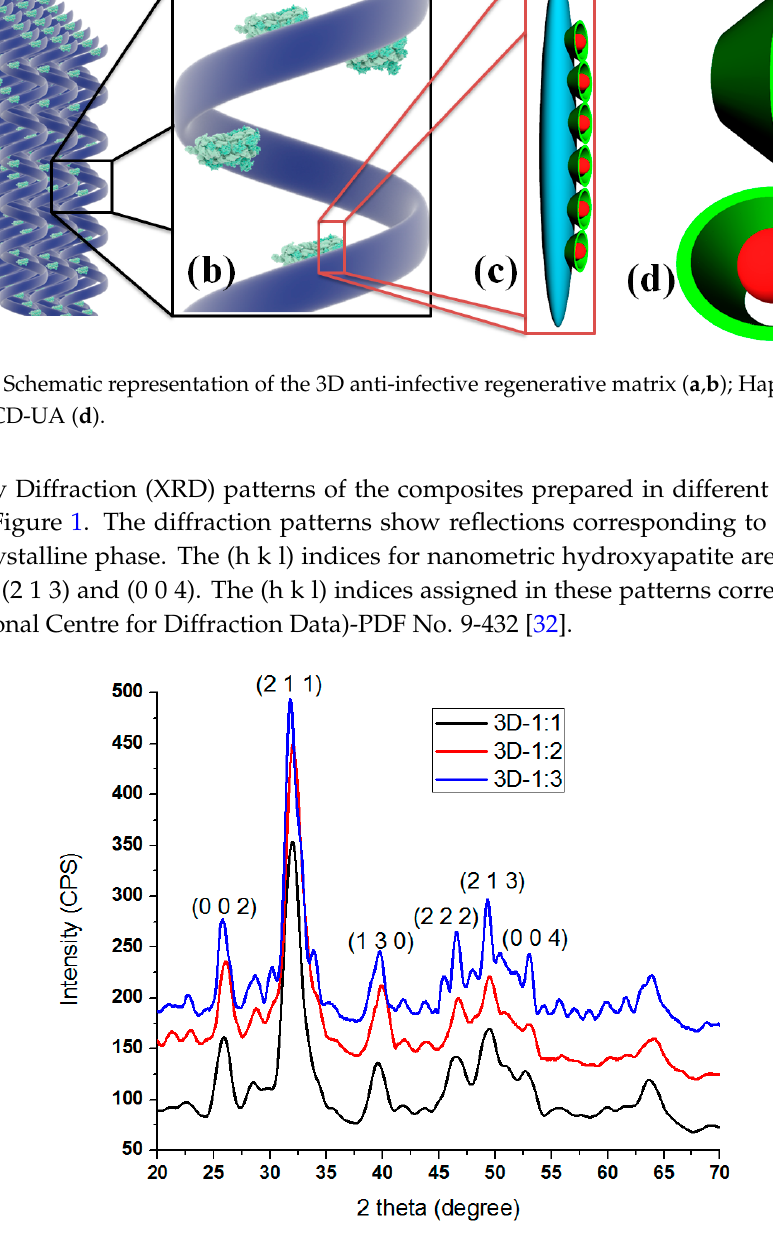
Figure 1. XRD pattern of 3D anti-infective regeneration matrix (based on hydroxyapatite, collagen, β -CD and UA)prepared in different mass ratios.